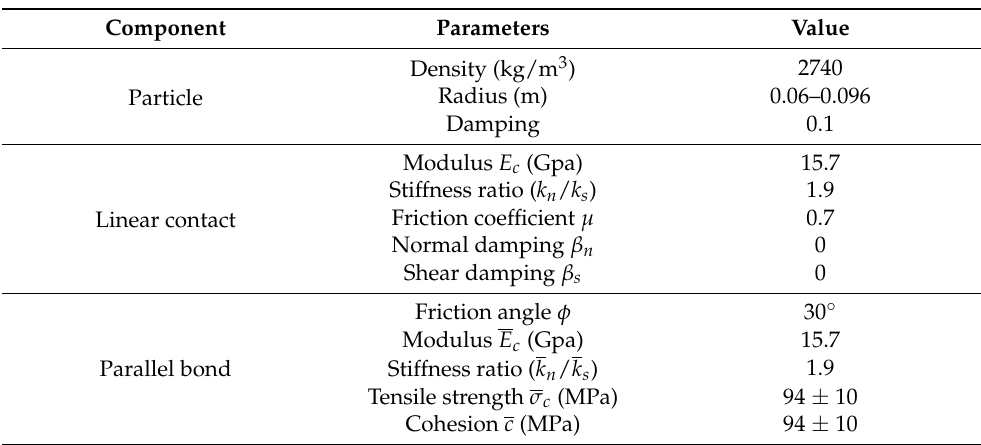
Table 2. Micro mechanical properties of PB